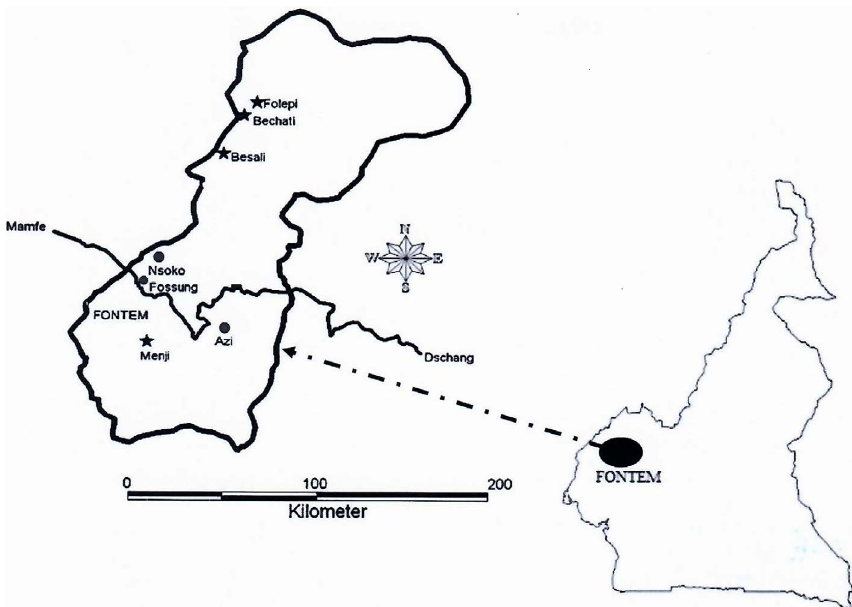
Figure 1. Map showing villages where entomological surveys where undertaken in the Fontem sleeping sickness focus. Stars: Villages where tsetse flies were trapped; circles: other villages. The road from Mamfé to Dschang is indicated in